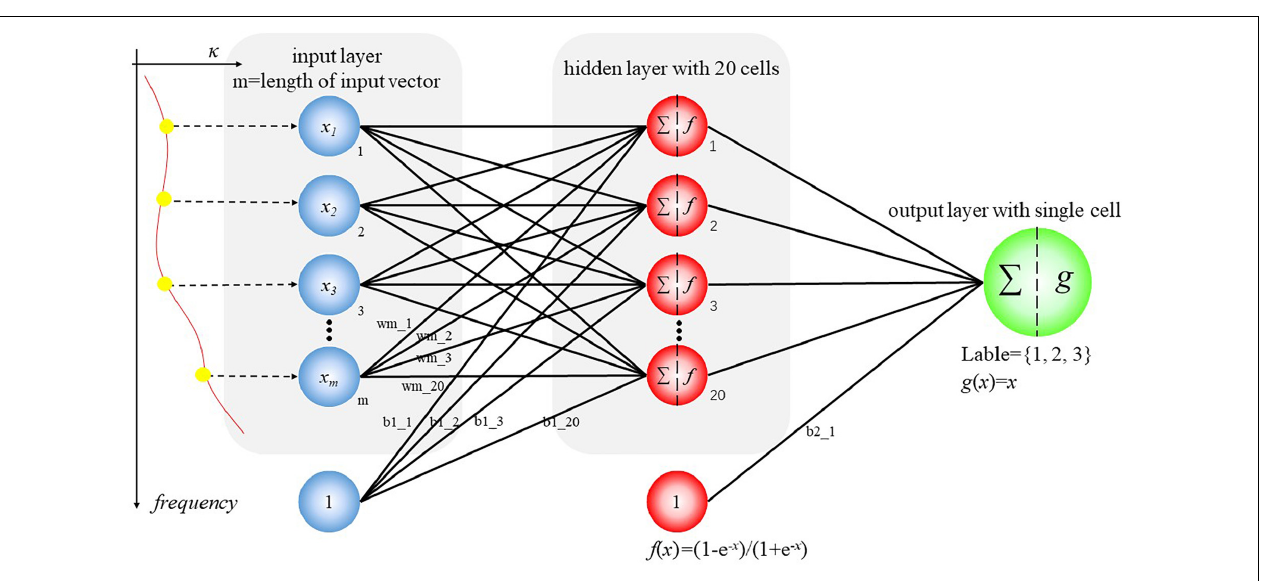
FIGURE 2 | Schematic of a feedforward neural network. A series of universal feedforward neural networks are built, trained, and employed to predict type of gelatin. The values at multiple frequency are viewed as input according to this figure. Besides, this figure also shows the definition of relevant